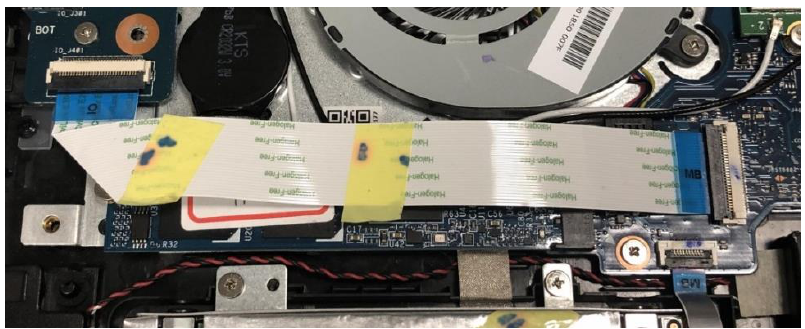
Figure 3. Poor design of signal line across cutting groove.